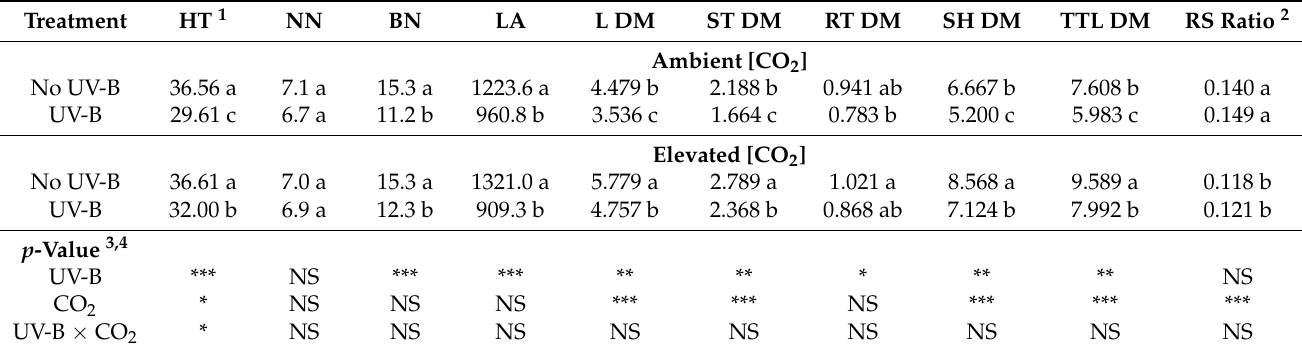
Table 1. The height (HT), node number (NN), branch number (BN), leaf area (LA), leaf dry mass (L DM), stem dry mass (ST